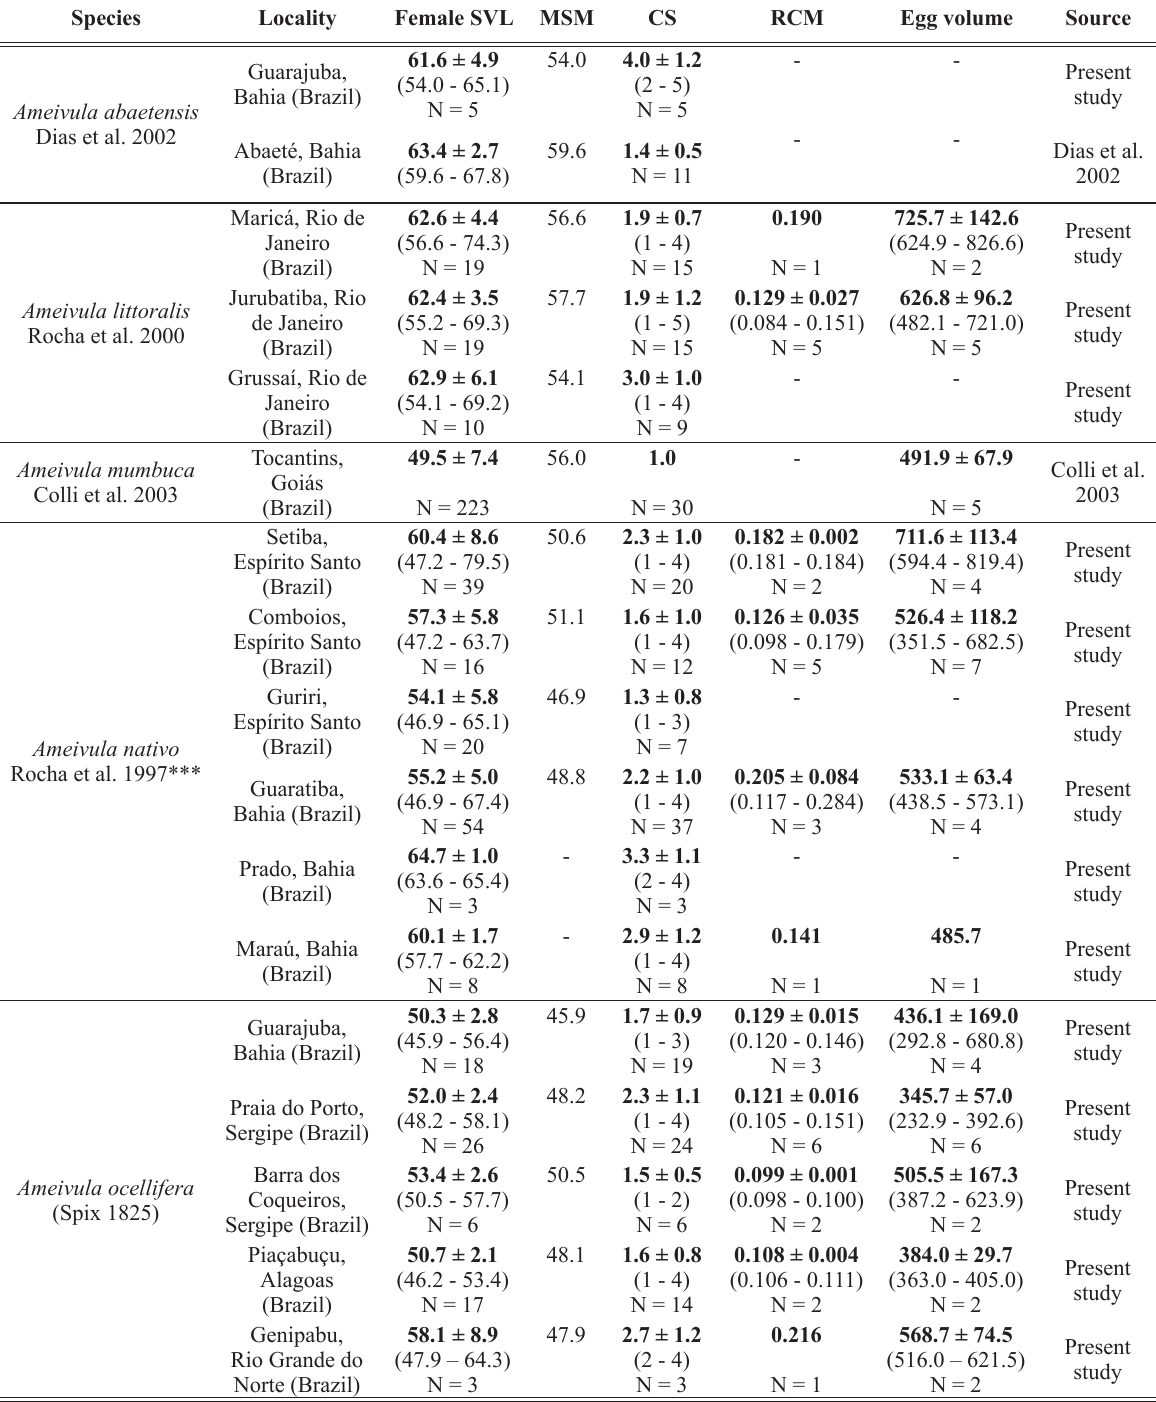
Figure 7 - Snout-vent length (SVL in mm) of females, minimum size at maturity (MSM, in mm), mean clutch size (CS), relative clutch mass (RCM) and egg volume (in mm 3 ) of different species and populations of cnemidophorines in South America and the Caribbean based on data from the literature. Values are represented by arithmetic mean + one standard deviation with the range in parentheses and sample size